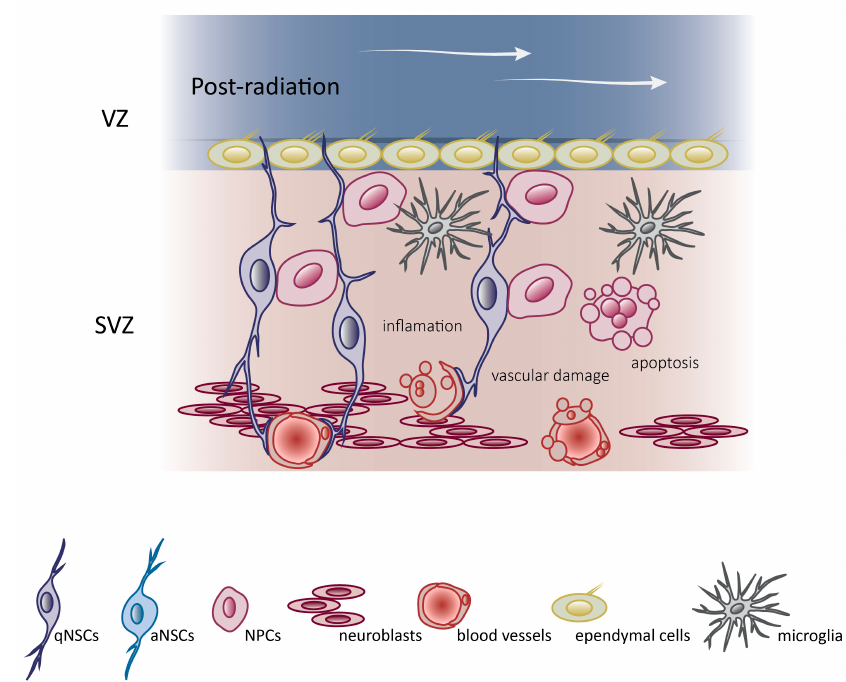
Figure 3. Radiation disrupts the V-SVZ niche. Schematic representation of mice V-SVZ niche after radiation. Following radiation, the V-SVZ niche shows a depletion of proliferating aNSCs, NPCs, and neuroblasts, a vascular damage and an increase in the number of microglia. Compare with schematic representation of mice V-SVZ niche in a pre-radiation condition (Figure